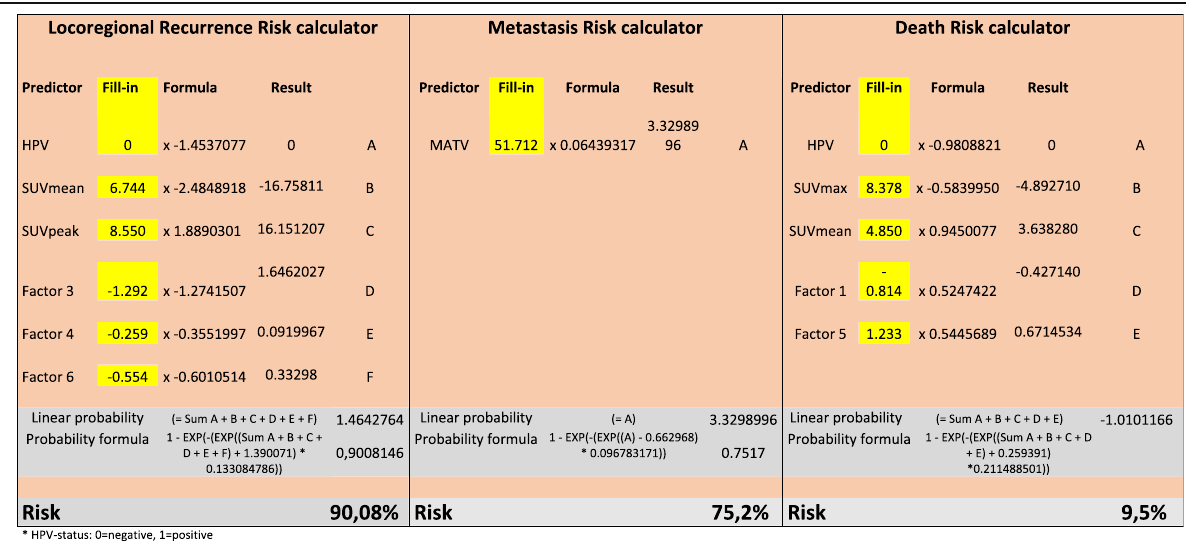
Table 5 The risk for locoregional recurrence calculator, which can be used in clinical practice to calculate the risk per specific patient for locoregional recurrence during the follow-up time of 2 years. The yellow boxes could be filled-in with the single patient data in order to calculate the risk for locoregional recurrence. The risk for metastasis calculator, which can be used in clinical practice to calculate the risk per specific patient for metastasis during the follow-up time of 2 years. The yellow boxes are filled-in with the single patient data (with a large tumor) in order to calculate the risk for metastasis. The risk for death calculator, which can be used in clinical practice to calculate the risk per specific patient for death during the follow-up time of 2 years. The yellow boxes could be filled-in with the single patient data in order to calculate the risk for death